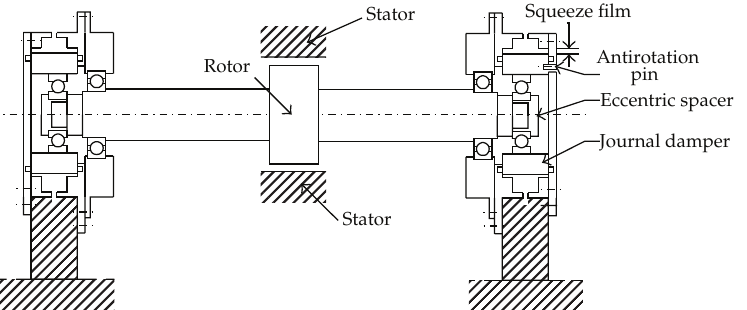
Figure 1: Schematic illustration of hybrid squeeze-film damper mounted the rotor-bearing system.